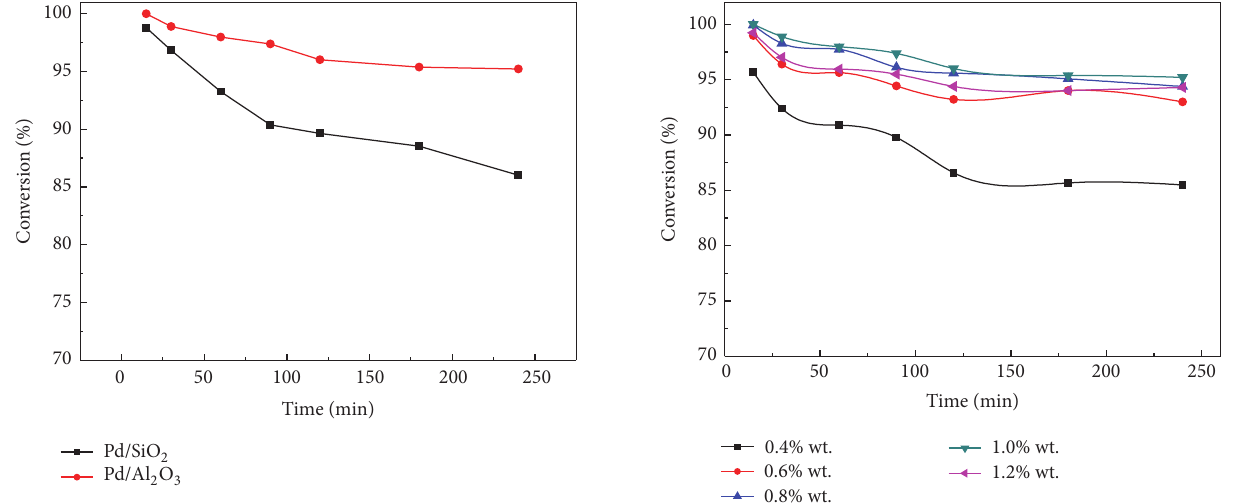
Figure 5: The hydrogen conversion of Pd/Al 2 O 3 in catalytic dehy- drogenation